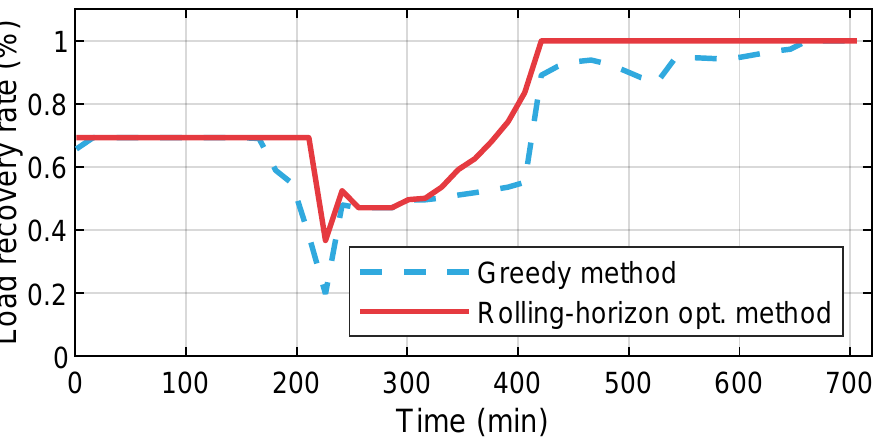
Figure 7. The comparison of load restoration between the greedy method and the proposed